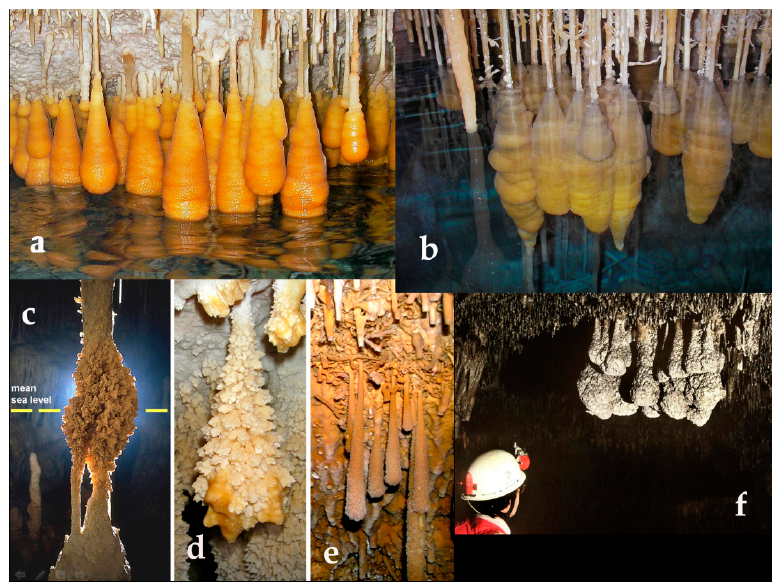
Figure 4. Photos of phreatic overgrowth on a speleothem (POS) in Mallorca. ( a,b ): Modern aragonite POS at Cova des Pas de Vallgornera (Llucmajor, Mallorca). Photos by Tony Merino and Bogdan P. Onac. ( c ) POS at +2.6 m in Cova des Pas de Vallgornera (Llucmajor, Mallorca), dated to MIS 5.5. Photo by Tony Merino. ( d,e ) Some POS at Cova des Pas de Vallgornera (Llucmajor, Mallorca). Photos by Bogdan P. Onac. ( f ) Ancient POS at Coves del Drac (Manacor, Mallorca). Photo by Joaquín Ginés. Rumena cave (Custonaci, Trapani, [6]): A single stalactite was collected at 98 m above sea level within a small cave. Unlike most of the other speleothems from the Mediterranean, which are covered by serpulids, the stalactite Geosciences 2021 , 11 , 77 from the Rumena cave has been encrusted by scleractinian corals (Figure 5g,h). The cross section of the sample revealed the presence of four highstands (MIS 25–37), with the outermost coral overgrowth, which represents the final marine ingression, being dated to 1.12 ± 0.2 Myr through the strontium isotopes ( 87 Sr/ 86 Sr) method. In Italy, the first speleothems sampled for sea level studies were retrieved from 15 submerged caves in the Tyrrhenian Sea (Figures 1 and 5) between 1992 and 1994 [19,63]. Between 2002 and 2017, a couple of studies on speleothems from the Argentarola and Custonaci caves, characterized by an alternation of continental layers, hiatuses, and en- crusting marine organisms allowed the sea level change during MIS 7 [2] and the Middle Pleistocene Transition [6] to be constrained.